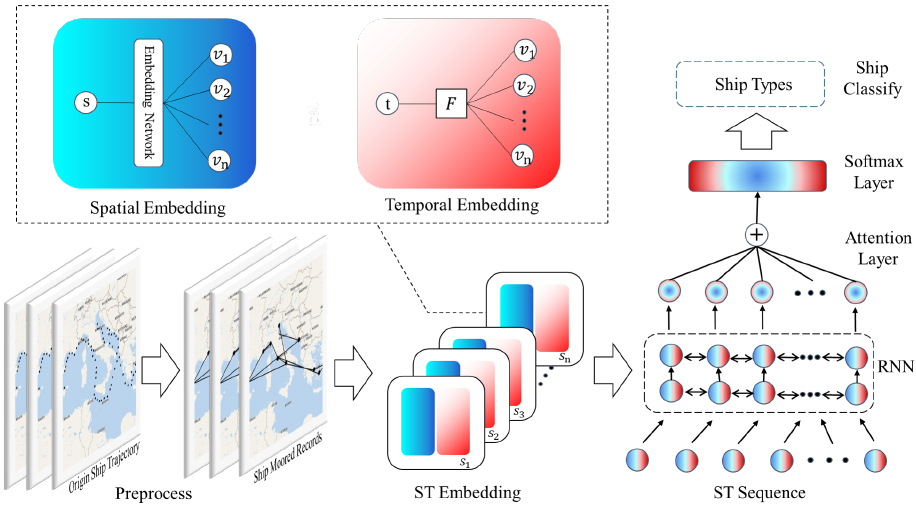
Figure 3. Overall structure of hierarchical spatial-temporal embedding method based on enhanced trajectory features for ship